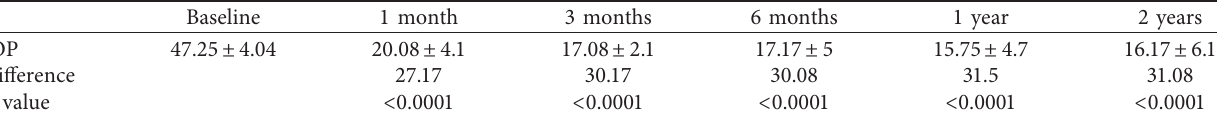
Figure 1: The mean BCDVA changes in LogMAR. Table 3: IOP (mmHg) changes overtime.